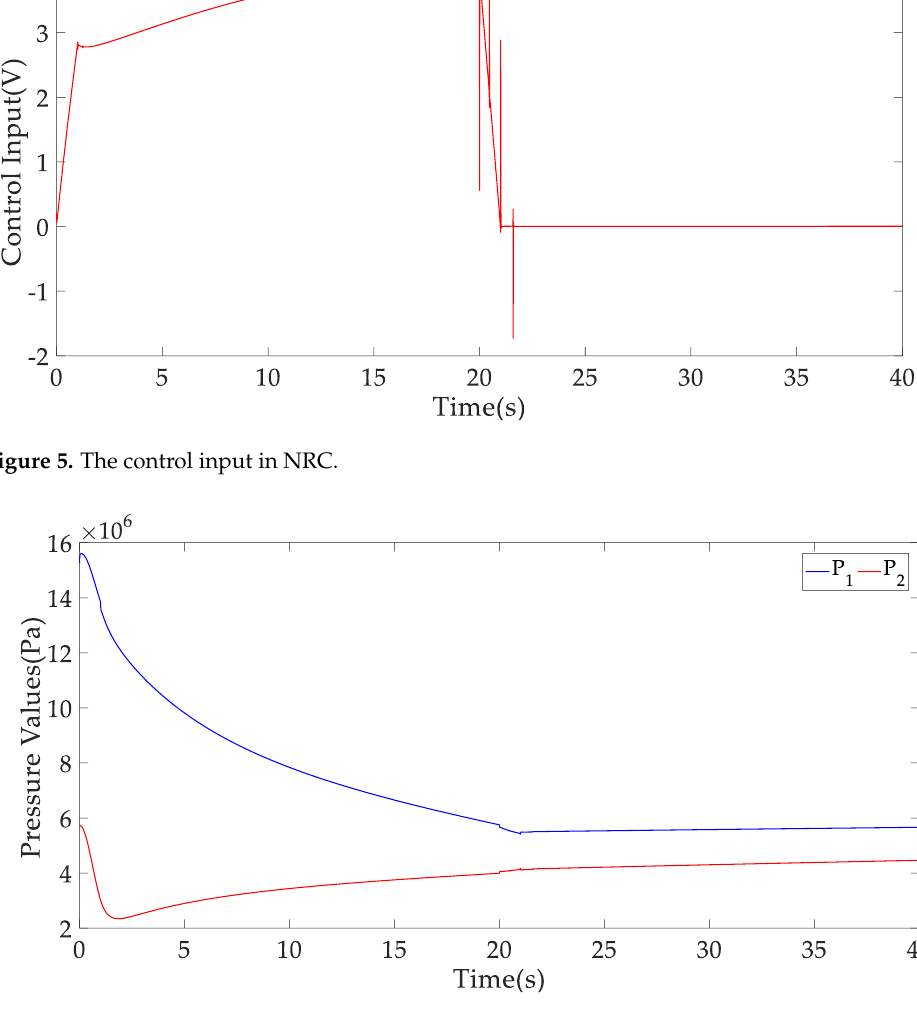
Figure 6. The pressure values of two chambers in NRC.